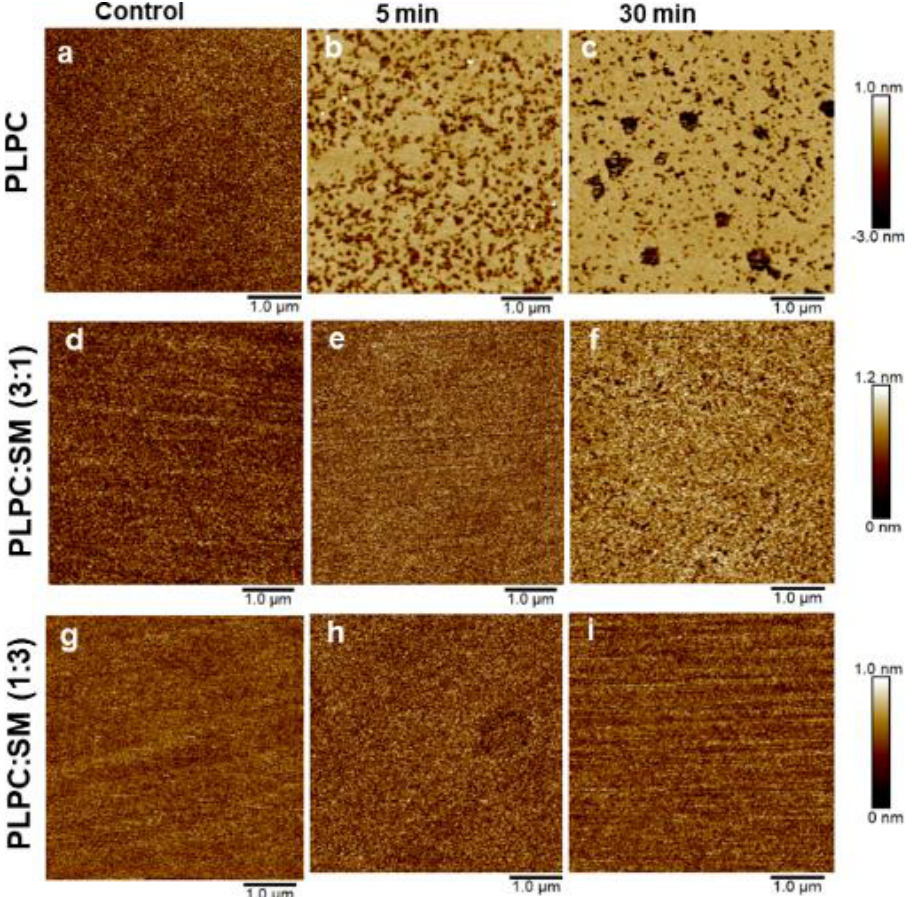
Figure 6. AFM images (5.0 × 5.0 µm 2 ) of supported PLPC bilayers with different SM fractions before (left) and after plasma treatment for different duration (centre 5 min; right 30 min). Measurements were performed in 50 mM phosphate buffer solution at room temperature. Note the different height scale; the assignment of the height scales is ( a , d , e , g , h , i : 0 to 1 nm), ( b , c : − 3 to 1 nm) and ( f : 0 to 1.2 nm).